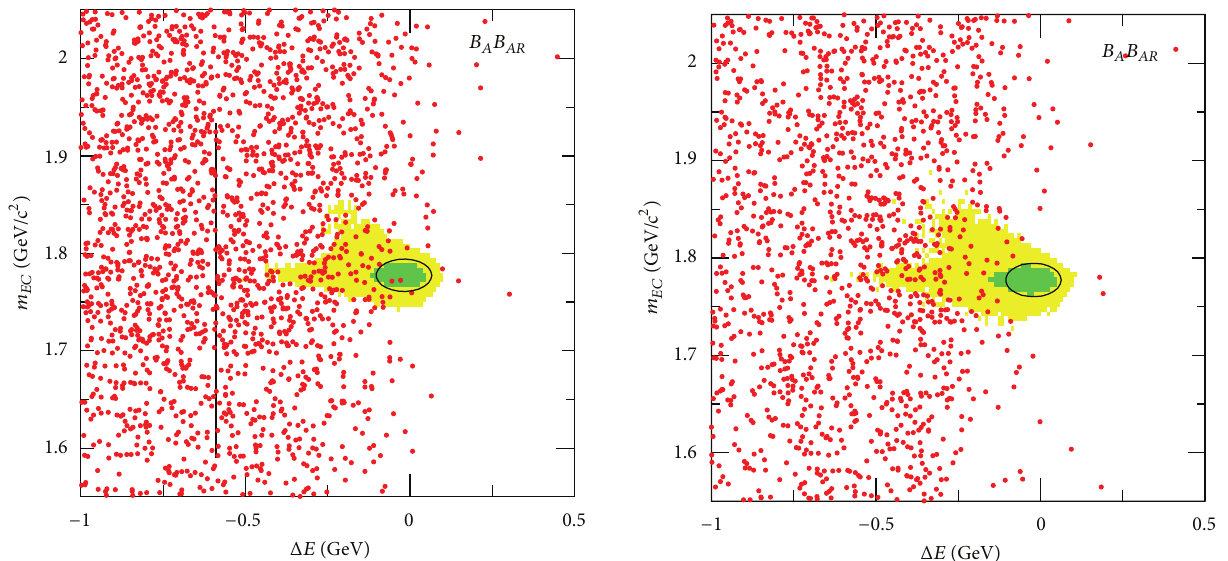
Figure 31: Results of the BaBar search for 𝜏 → 𝜇𝛾 (left) and 𝜏 → e 𝛾 (right) CLFV decays [121].